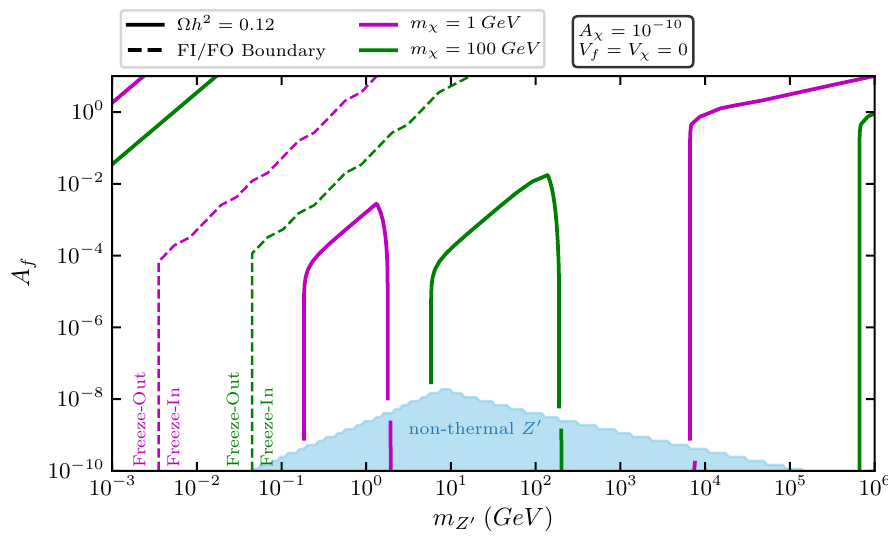
Figure 3. Observed relic abundance contours for an axial Z 0 , where Ω 0 and regime boundaries (dashed curves), on A f vs m Z 0 plane. Two DM masses are shown where m χ = 1 GeV is drawn in magenta, and m χ = 100 GeV in green. DM particles are regarded as WIMPs (FIMPs) in the region to the left (right) of the regime boundary. In the blue region, Z 0 is not part of the SM thermal